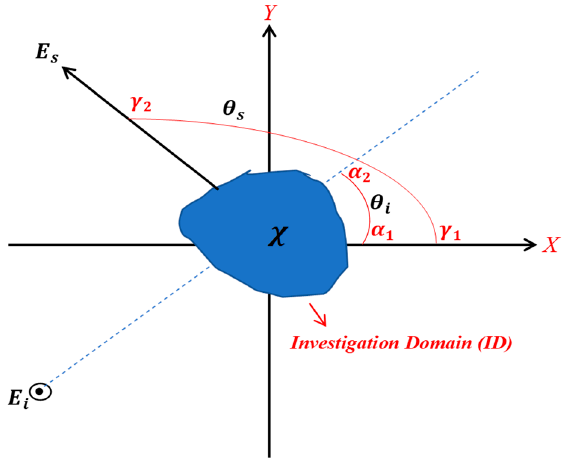
Figure 1. The geometry of the general inverse scattering problem.